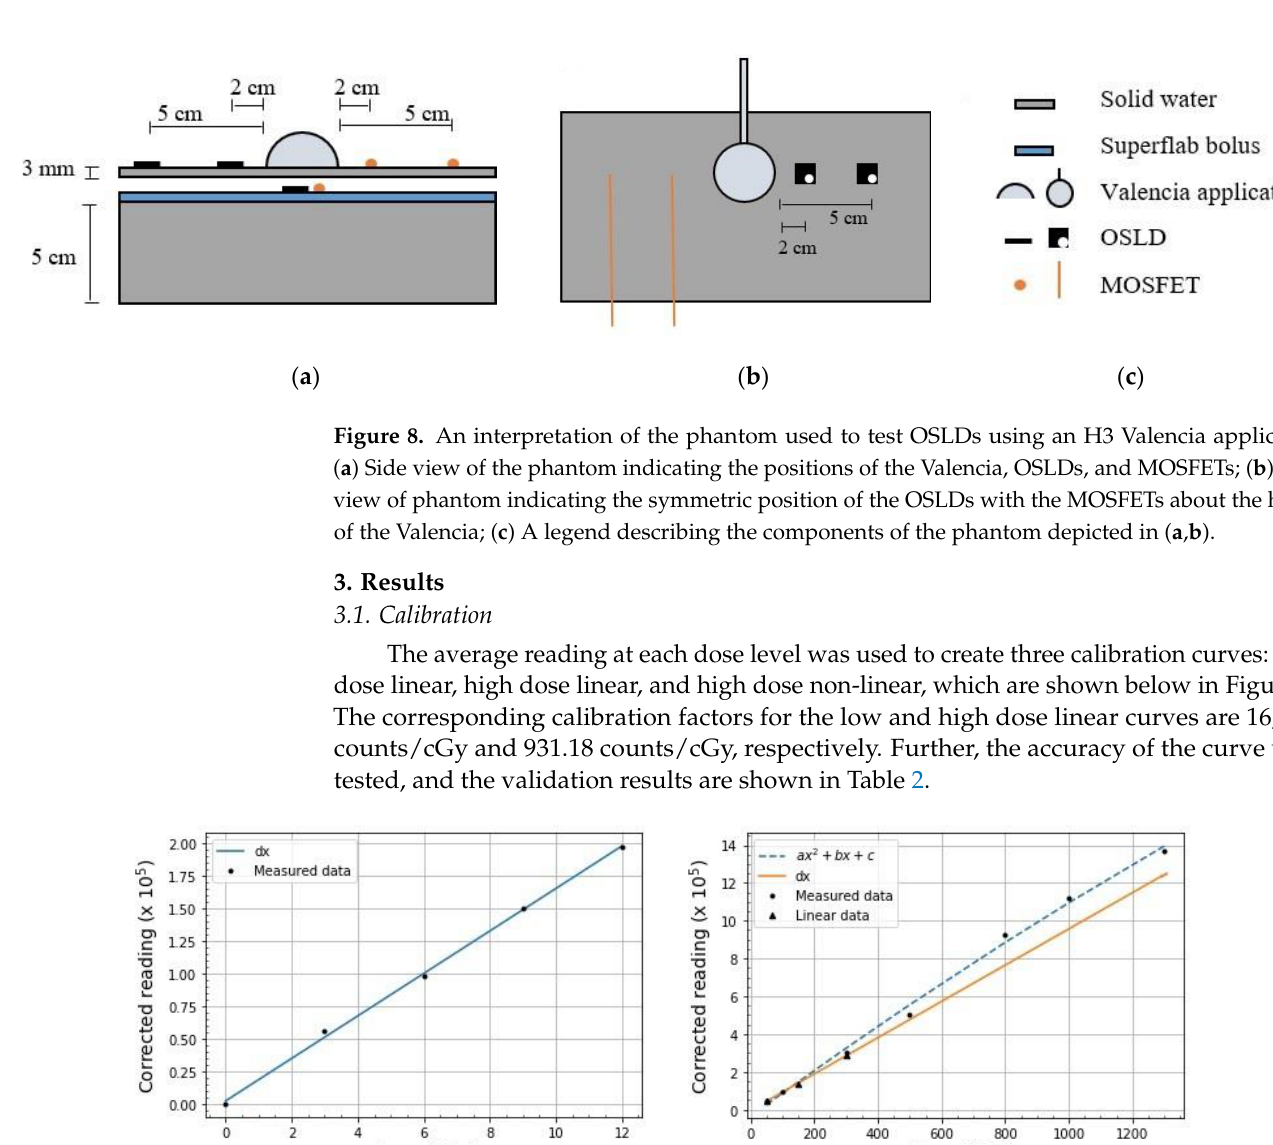
( b ) Figure 7. The phantom used to test OSLDs using a Freiburg flap applicator. ( a ) Top view of the phantom indicating the position of the pacemaker; ( b ) Bottom view of phantom indicating the position of the target. The second case was to measure the dose to the lens of the eye when treating a facial skin lesion with a 3 cm horizontal (H3) Valencia applicator. The phantom used is depicted in Figure 8. This test used both OSLDs and MOSFETs to measure the dose to three areas of interest, the target area, the OAR (lens), and the surface dose. The target area was lo- cated under 3 mm of solid water directly beneath the center of the Valencia. The hypo-